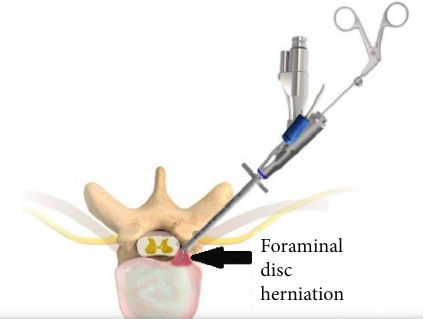
Figure 5: Schematic illustration of the transforaminal endoscopic surgical approach and instruments for a foraminal disc